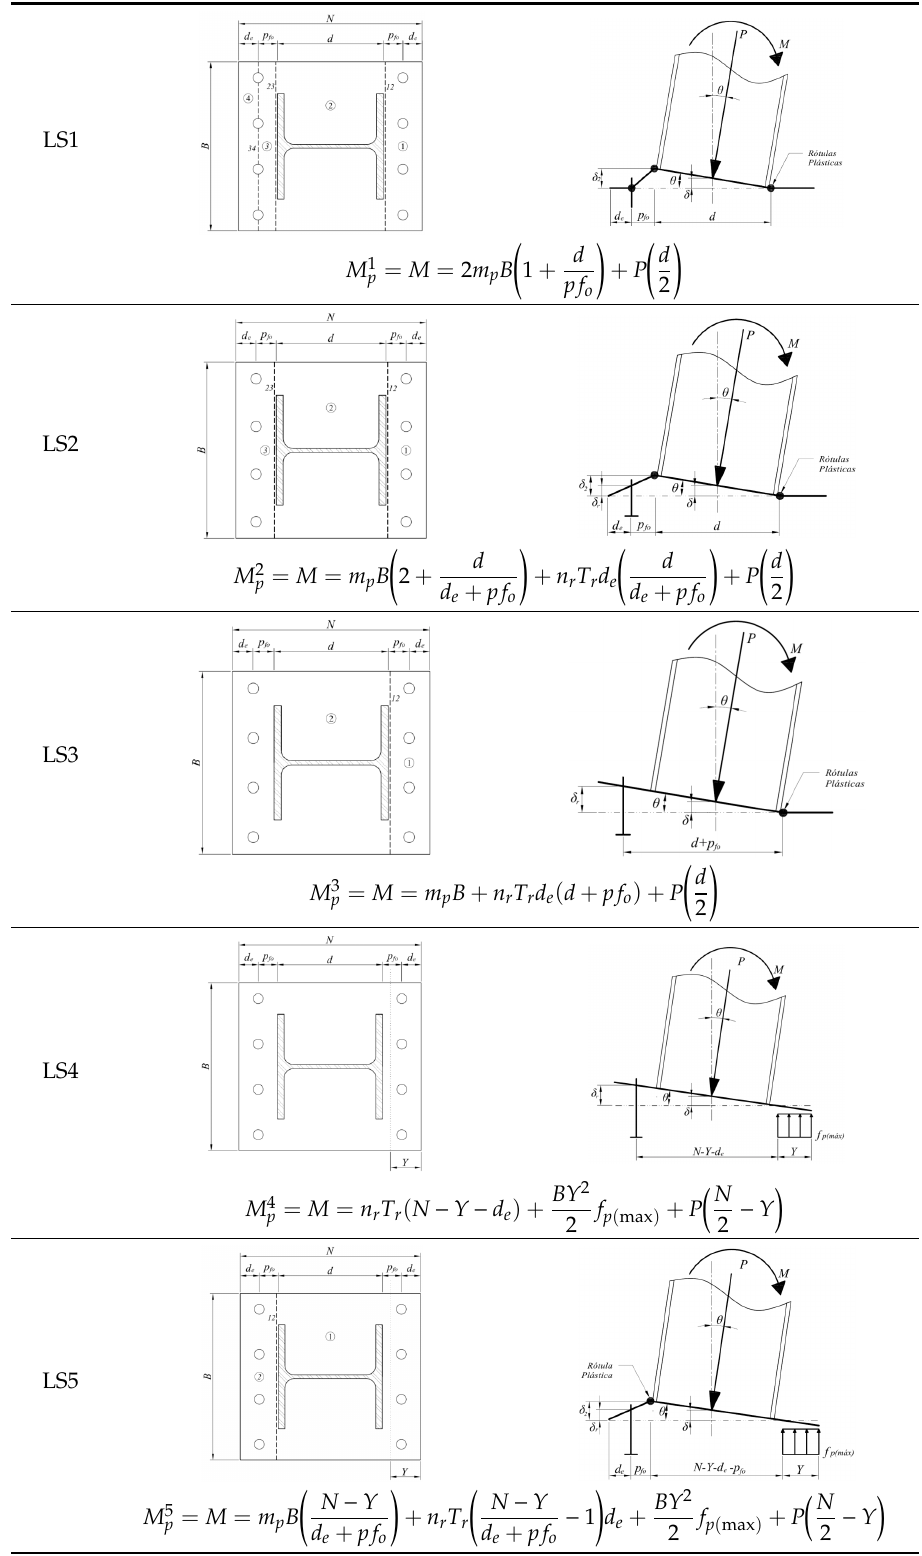
Table 2. Limit states that control the design of base plate type UBP-1.